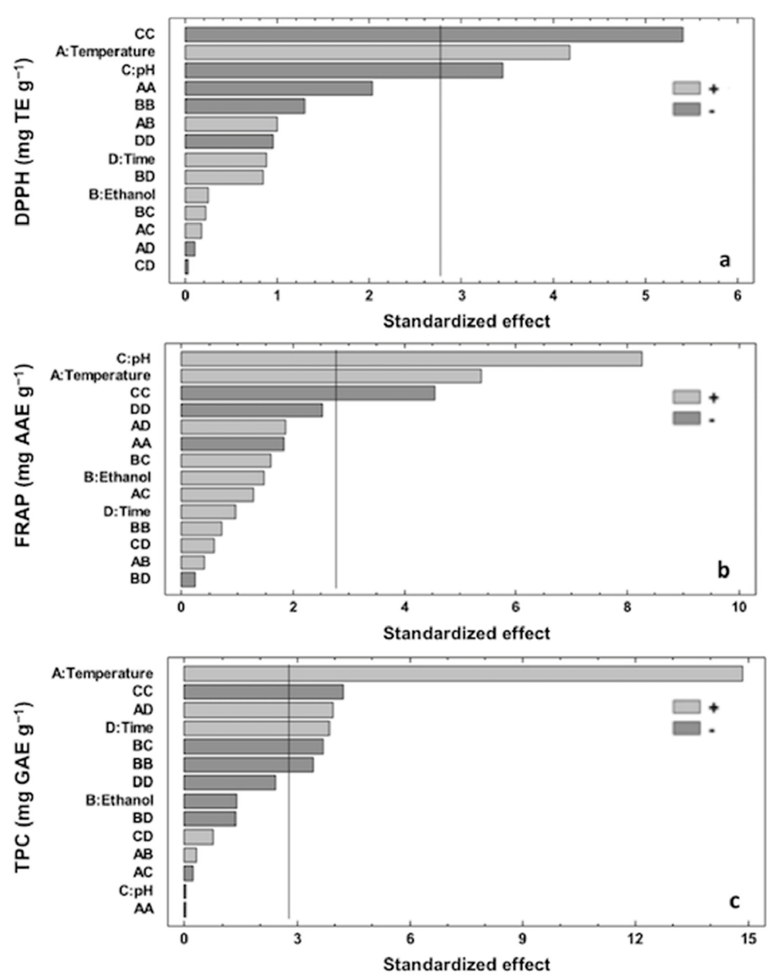
Figure 2. Pareto charts obtained for ( a ) DPPH (mg TE g − 1 ), ( b ) FRAP (mg AAE g − 1 ), and ( c ) TPC (mg GAE g − 1 ) values of ASE by MAE. The vertical line indicates the statistical significance at 5% of the effects.